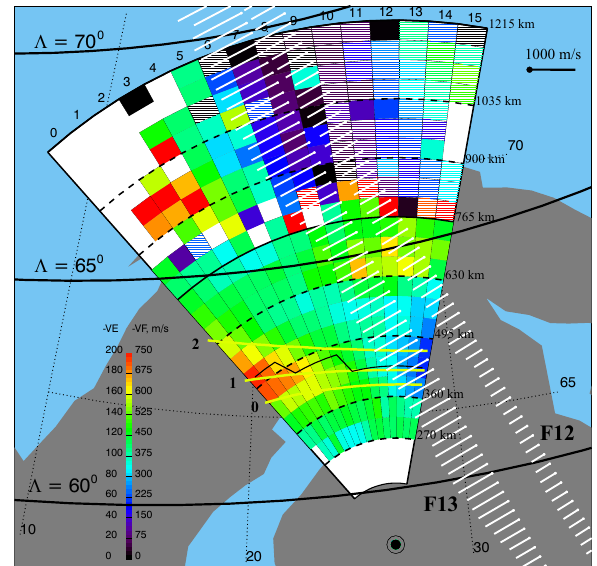
Fig. 1. Field of view plot of the averaged Doppler velocity observed by the CUTLASS Finland radar during the interval 14:40–14:50 UT on 31 March 2000. Each radar cell is color coded according to the color bar shown in the left bottom part of the diagram. The color scheme for r = 180 − 765km ( r = 765 − 1215 km) is indicated by the digits to the left (right) of the color bar. The echoes in cells filled by the horizontal lines have, on average, positive velocities corre- sponding to the color of the line. Also shown are slant range marks (dashed circular curves) and PACE lines of equal magnetic latitudes 3 = 60 ◦ , 65 ◦ , and 70 ◦ (solid thick curves). Thick yellow curves 0–2 denote the off-perpendicular (aspect) angle line α = 0 ◦ (see text for details). Thin ragged solid black line shows the location of the av- erage power maxima along each radar beam. Two DMSP passes (F13: 14:43–14:48 UT and F12: 17:05–17:10 UT) with the mea- sured perpendicular ion velocities are indicated by white vectors. The scale for the ion velocities is shown in the top right corner of the